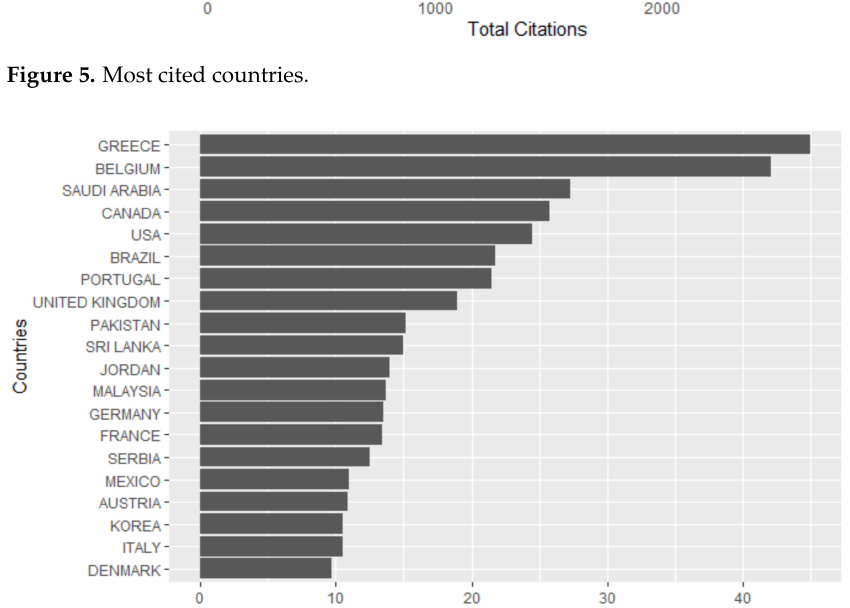
Figure 6. Citations per paper